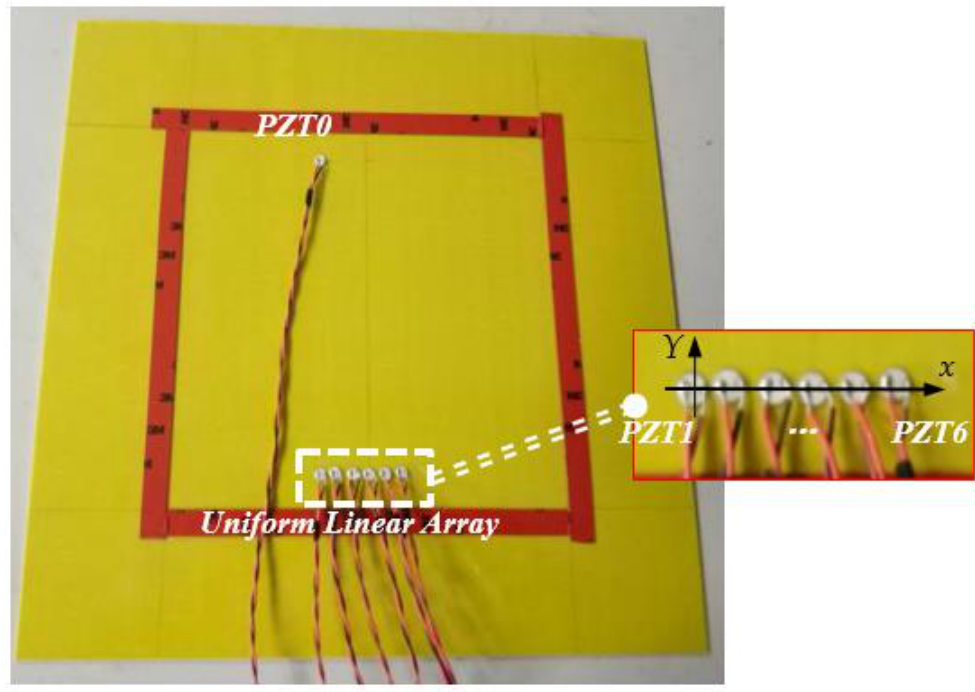
Figure 2. Overall view showing the plate, active sensor PZT0, and an uniform linear array.